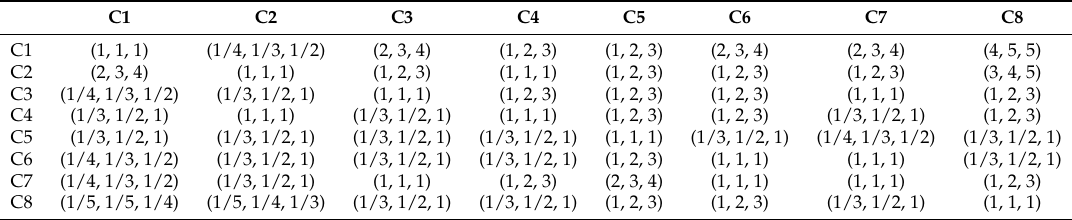
Table 5. Relative importance of each pair of the considered criteria (TFN).